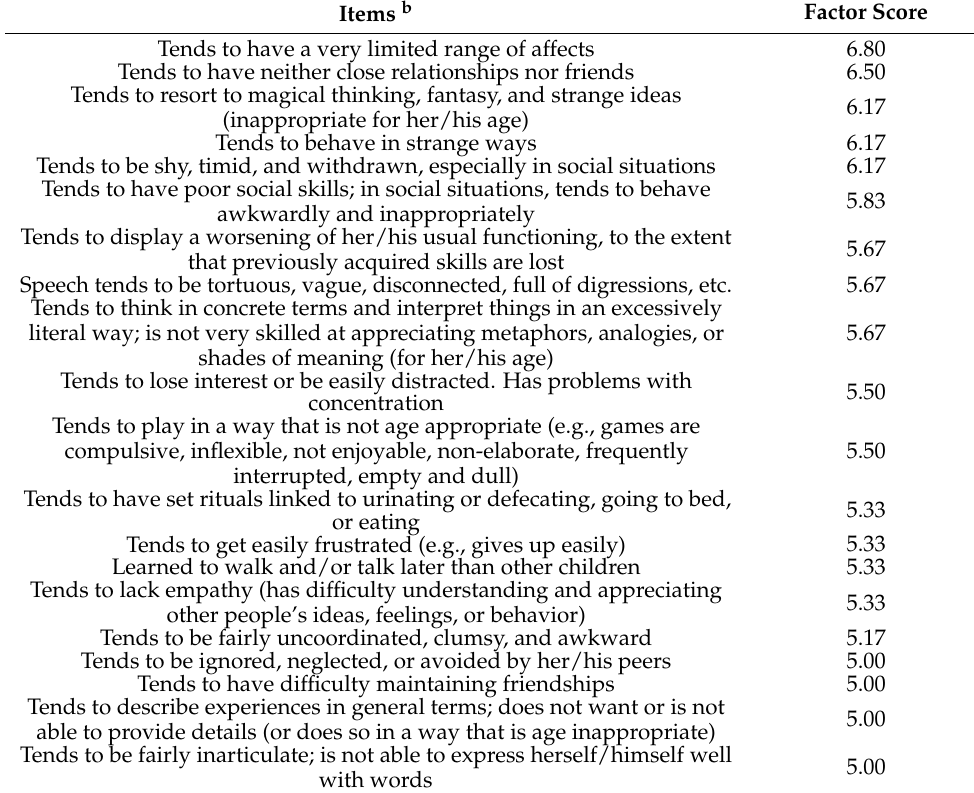
Table 4. Best CPAP-Q a items of the schizoid